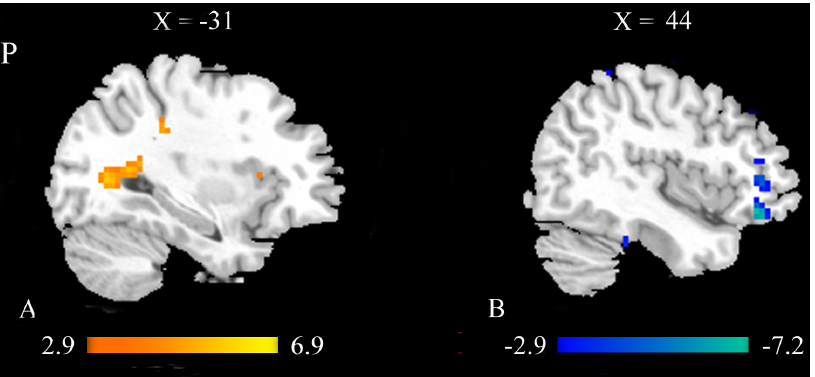
Figure 7. Brain areas with significant different ReHo values between MCI and HC groups during the resting state following acupuncture. Warm and cool colors respectively indicate the significantly increased (A) and decreased (B) ReHo values in MCI patients compared with healthy controls at P , 0.01 (Alphasim corrected, p , 0.01, 30 voxels). (Abbreviation: MTG- Middle Temporal Gyrus, MFG- Middle Frontal Gyrus). doi:10.1371/journal.pone.0099335.g007 PLOS ONE |